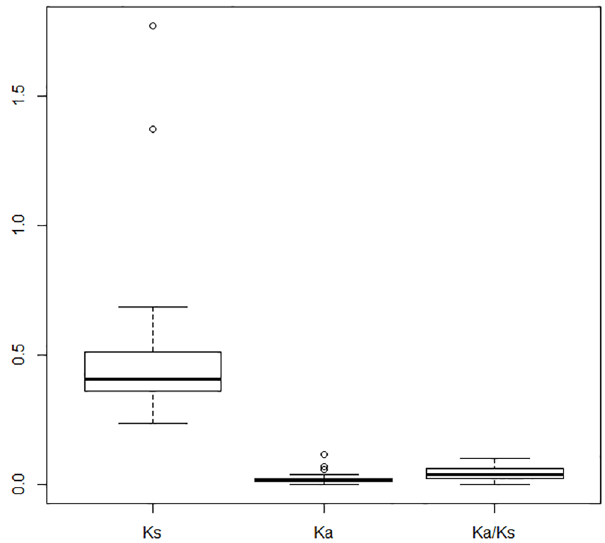
Fig 5. Ka/Ks results of the 39 salt and osmotic stress genes in B . humilis versus A . thaliana orthologs.